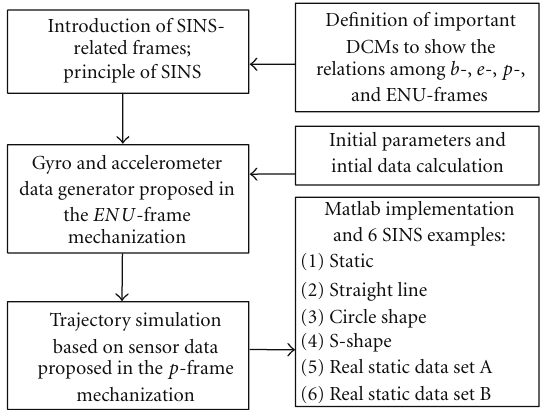
Figure 1: The schema of the proposed mathematical model and Matlab simulation of SINS.